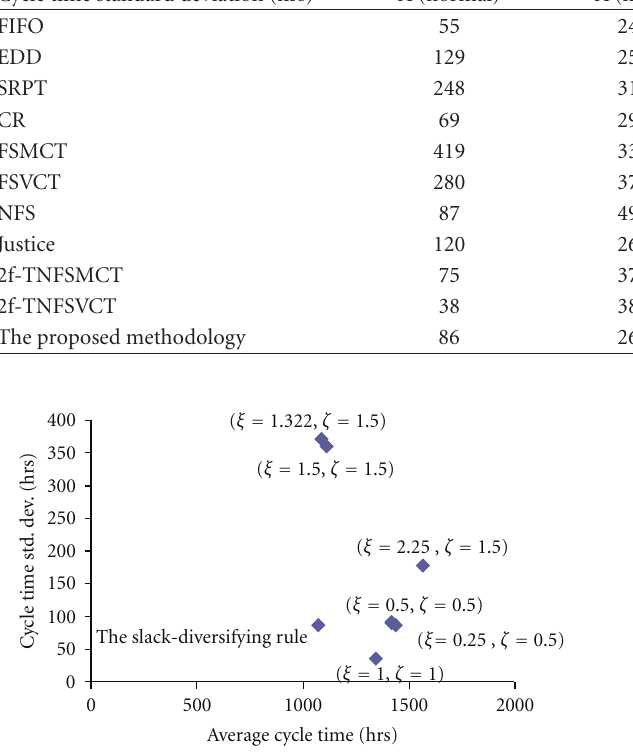
Figure 2: Comparing the slack-diversifying rule with traditional rules without slack